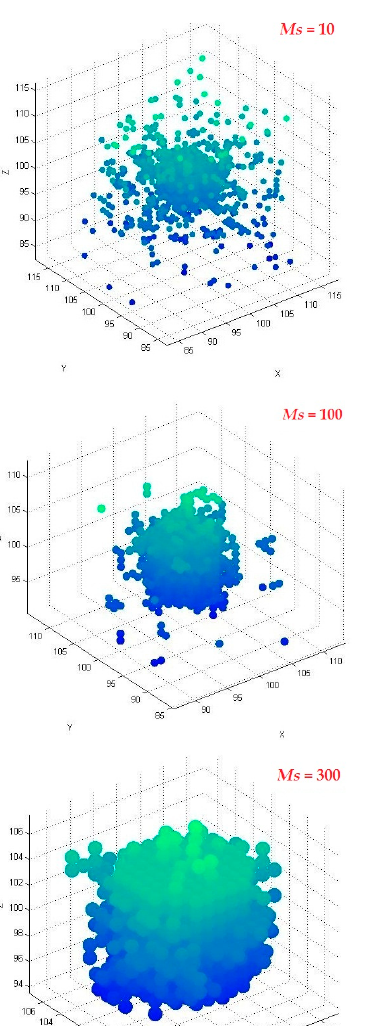
Figure 11. 2D DLA aggregates with diverse finite motion step numbers.